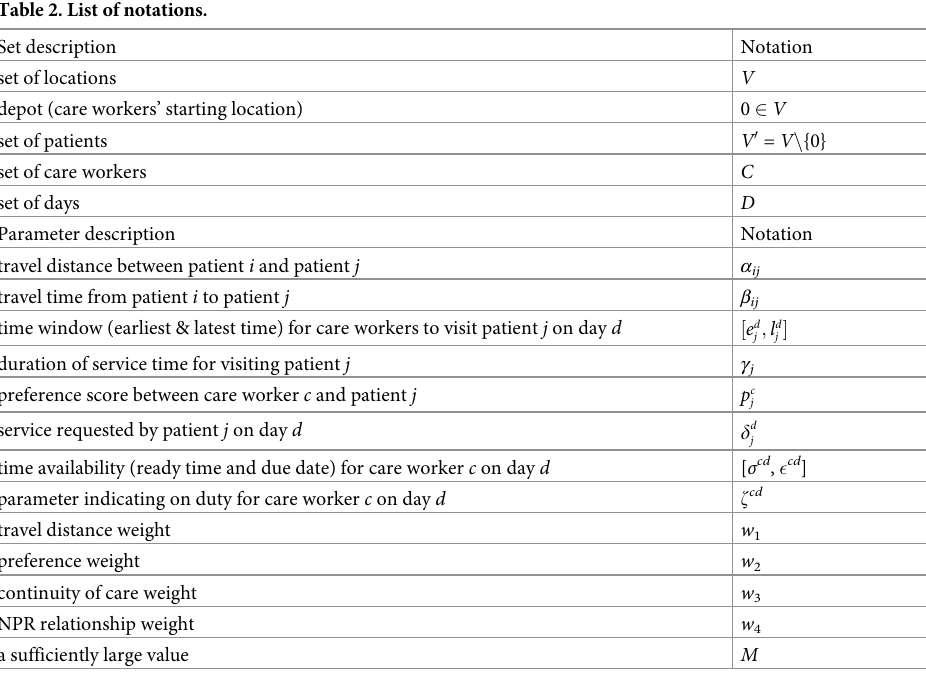
Table 2. List of